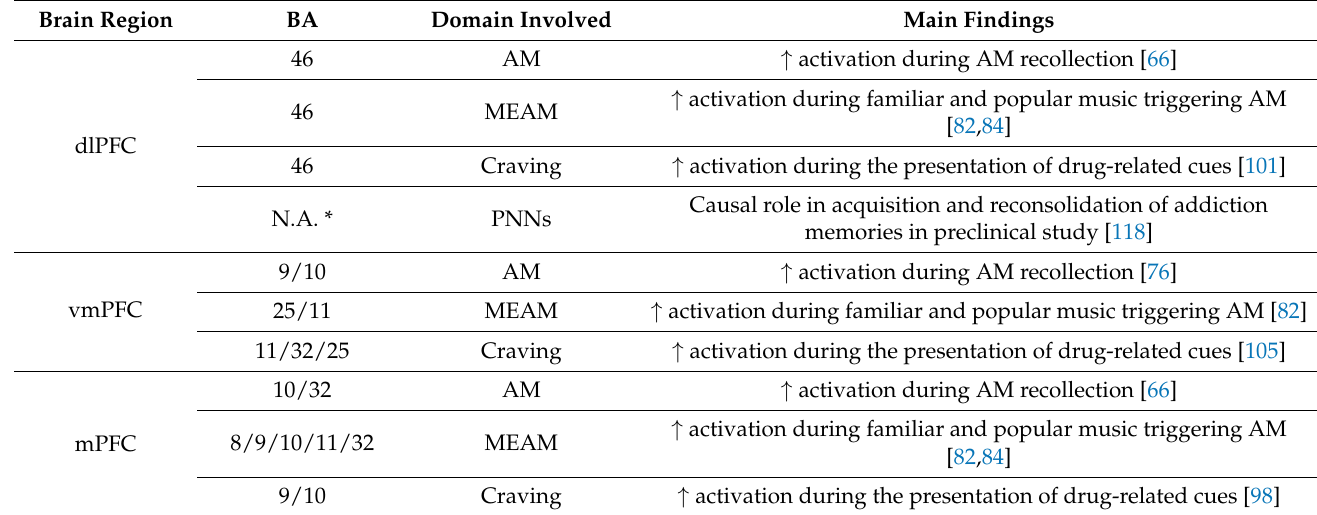
Table 1. Evidence for the overlap between brain structures involved in the feeling of craving, autobiographical memory retrieval, and